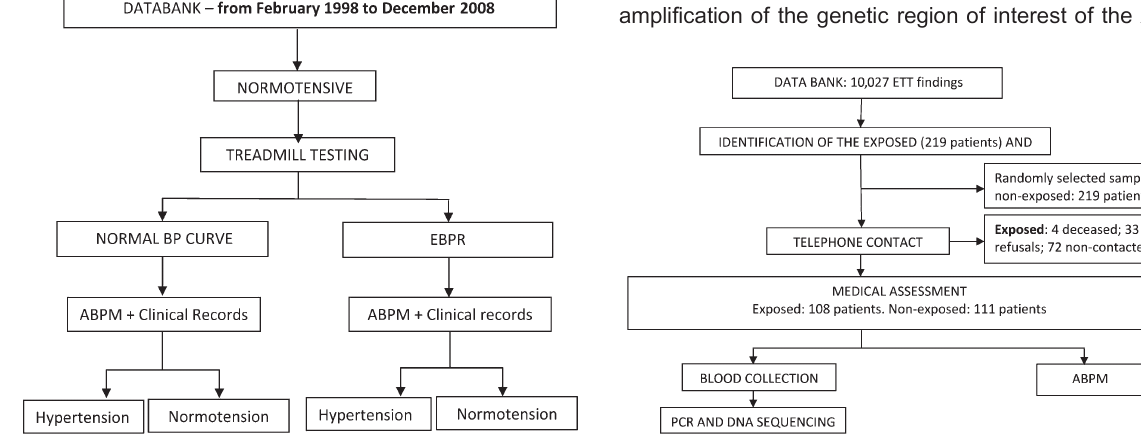
Figure 2. Flowchart of data collection. ETT = exercise treadmill test; ABPM = ambulatory blood pressure